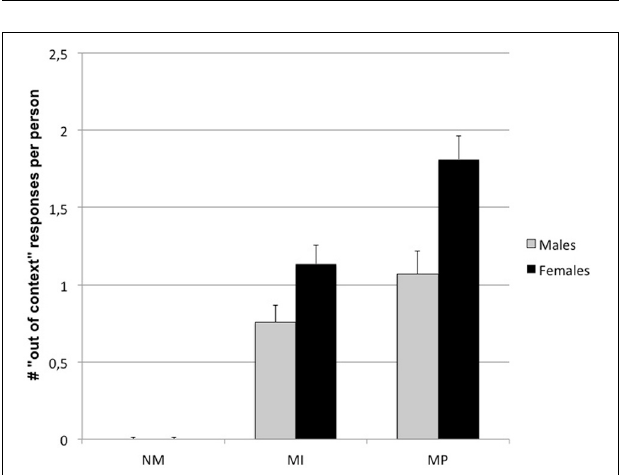
FIGURE 5 | Condition × Gender interaction on “Out of context” responses. (NM, Non Moral; MI, Moral Impersonal; MP, Moral